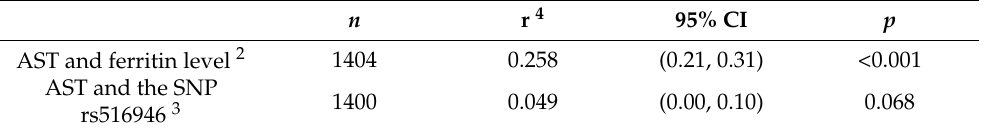
Table 6. Pearson Correlation of AST with ferritin level and SNP rs516946 in the male participants 1